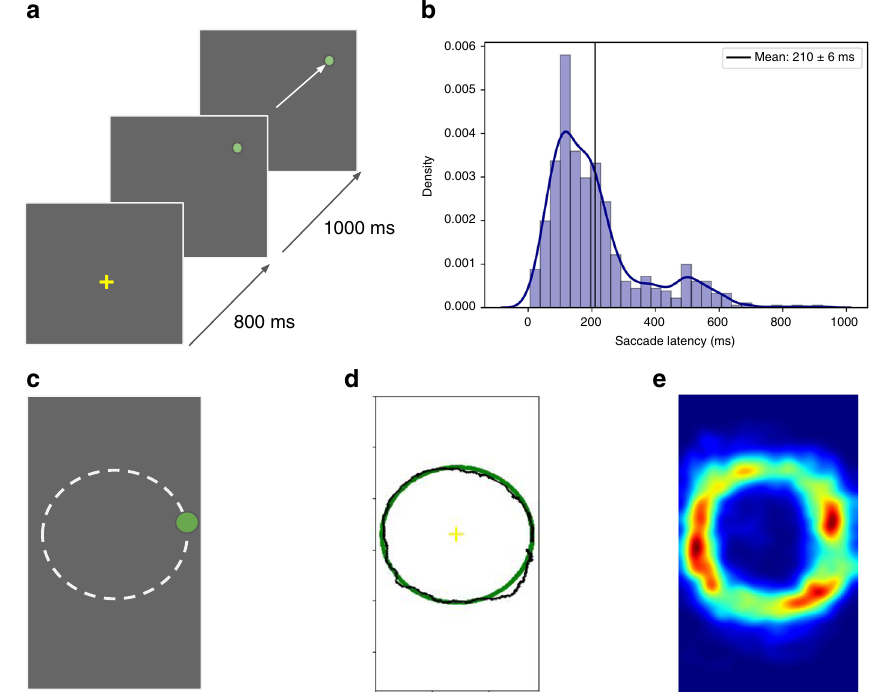
Fig. 3 Smartphone gaze for standard oculomotor tasks. a Prosaccade task. Each trial began with a central fi xation for 800 ms, after which the target appeared at a random location and remained for 1000 ms. Participants were asked to saccade to the target as soon as it appeared. b Saccade latency distribution for the prosaccade task. c Smooth pursuit task. Participants were asked to look at the green dot as it moved along a circle. d Sample scanpath from a single user shown in black (ground truth in green). e Population-level heatmap from all users and